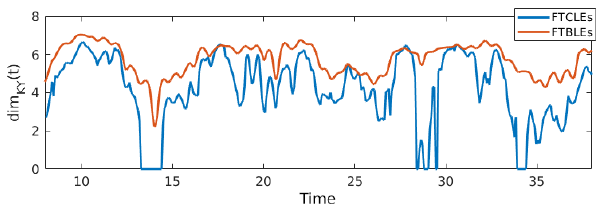
Figure 6. Comparison of the finite-time Kaplan–Yorke dimension calculated using the growth rates of CLVs (FTCLEs) and the QR method